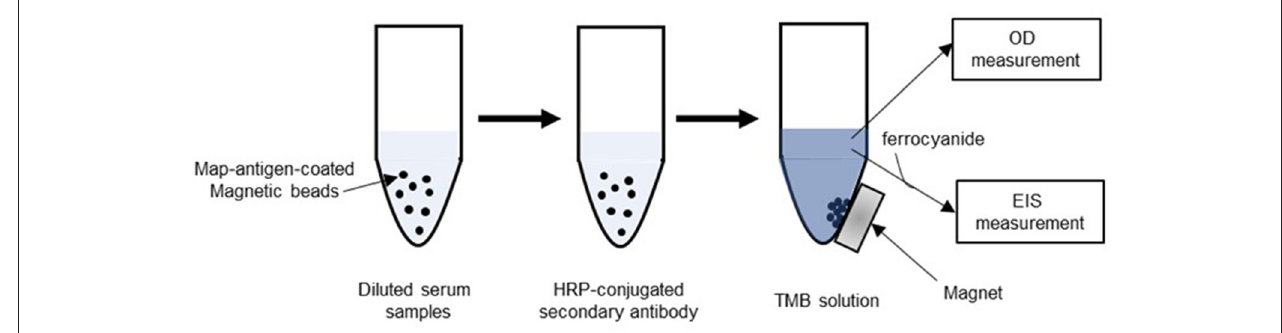
FIGURE 1 | Schematic of bead-based antibody binding assay. Magnetic beads coated with antigen of Mycobacterium avium subsp. paratuberculosis (MAP) were treated with diluted bovine serum samples from Johne’s disease (JD)-positive and negative animals. After removal of the serum solution, the beads were then incubated with secondary antibody (anti-bovine immunoglobulin antibody) conjugated with horseradish peroxidase (HRP). After washing, the beads were reacted with 3,3 ′ ,5,5 ′ -tetramethylbenzidine (TMB) followed by a 6-min incubation. The TMB solution was subjected to the colorimetric or electrochemical measurement. For the electrochemical measurement, a ferrocyanide solution was added to the TMB solution prior to the